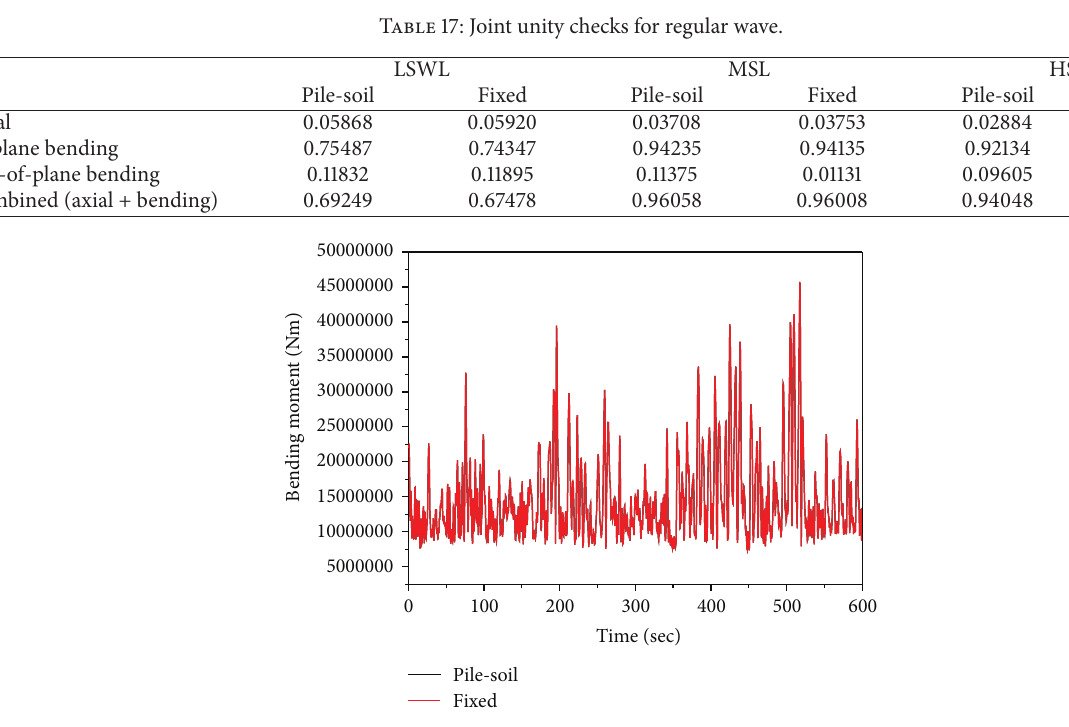
Figure 15: Maximum bending moments with irregular wave at HSWL.